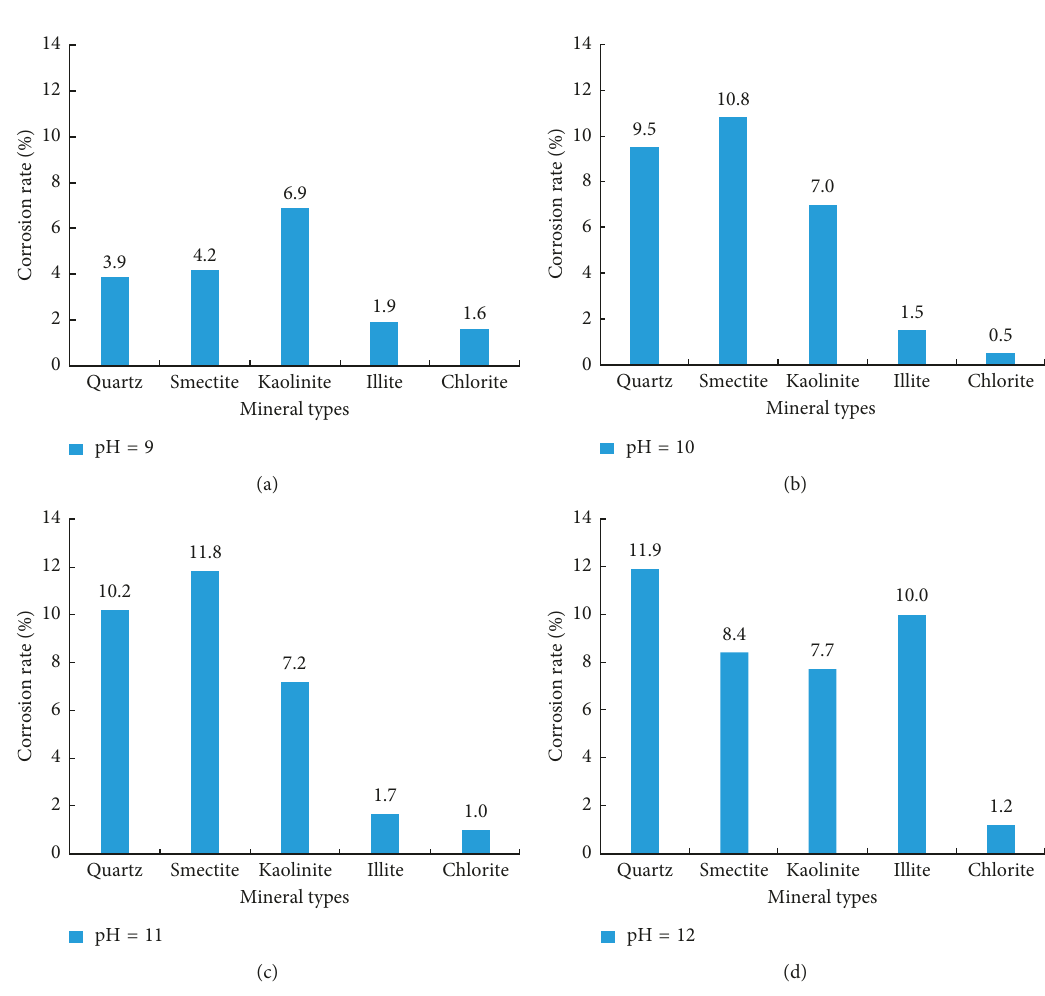
Figure 3: Corrosion rate of mineral under different